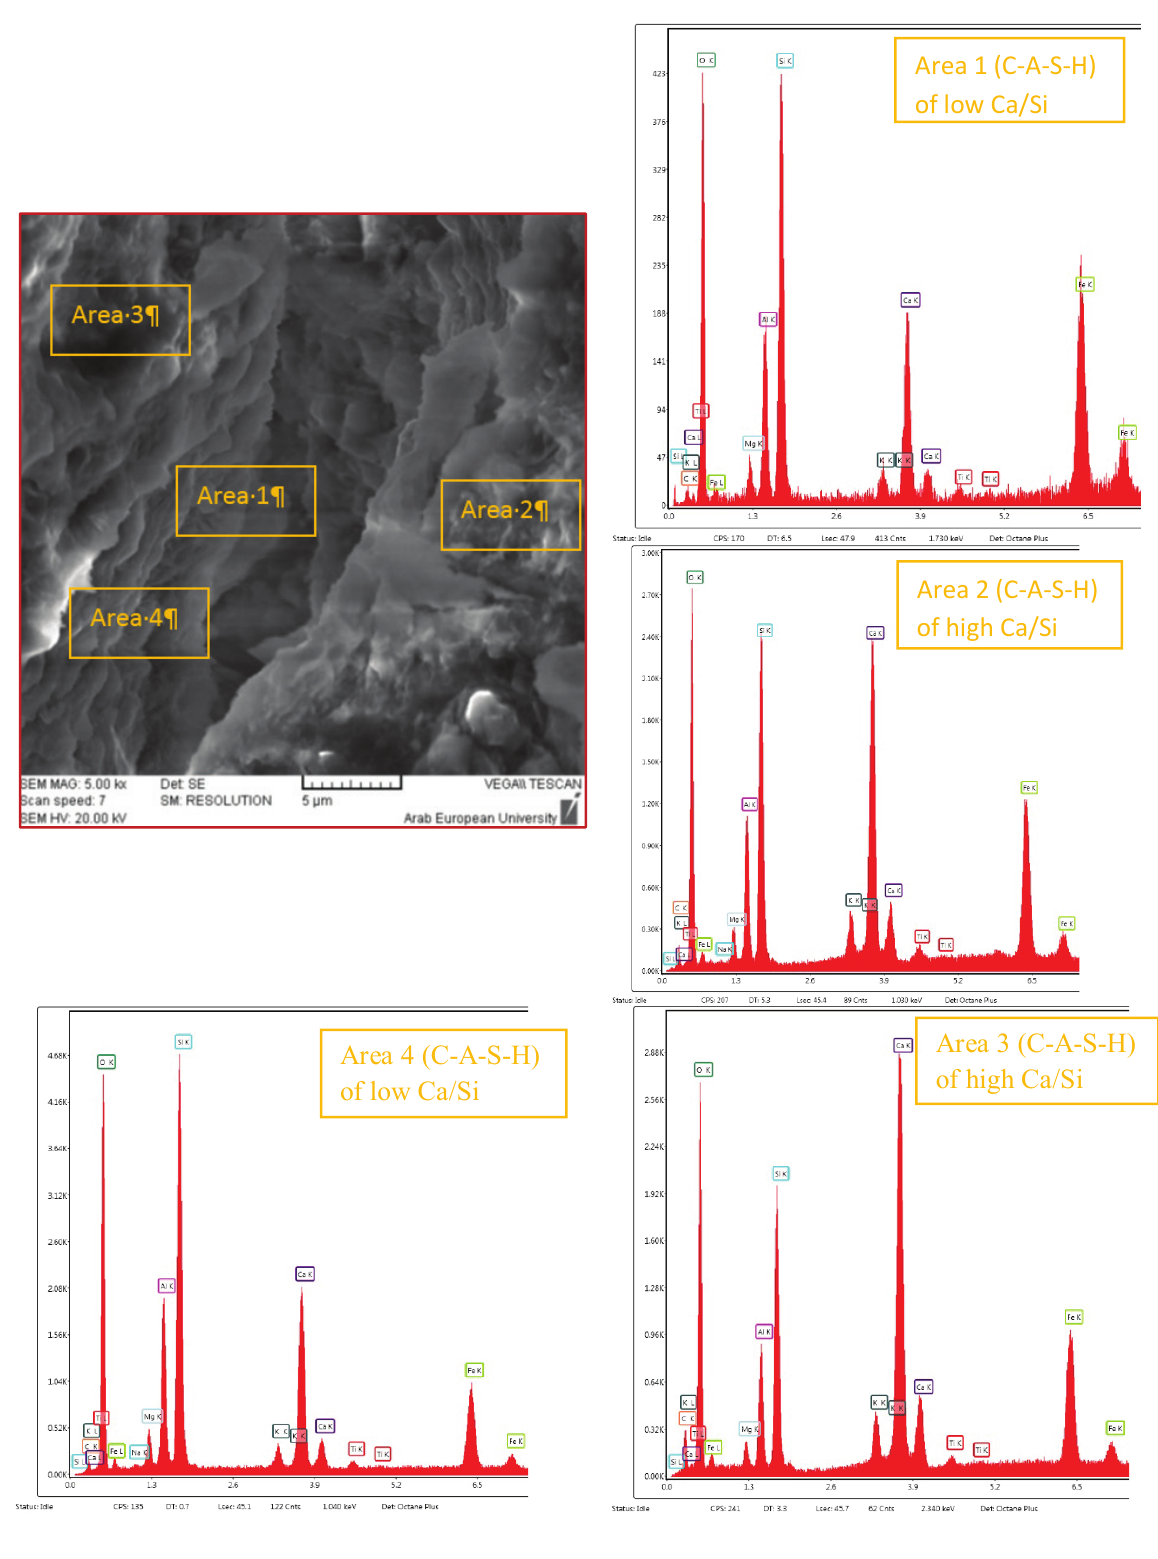
Figure 10. SEM micrograph and EDX analysis of CC20L6 mixture (soil 2) cured for 7 days. Figure 11: SEM micrograph and EDX analysis of CC20L6 mixture (soil 2) cured for 7